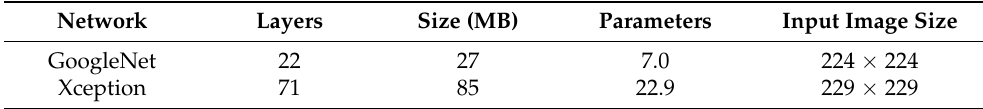
Table 1. Characteristics of the two networks used for comparison.